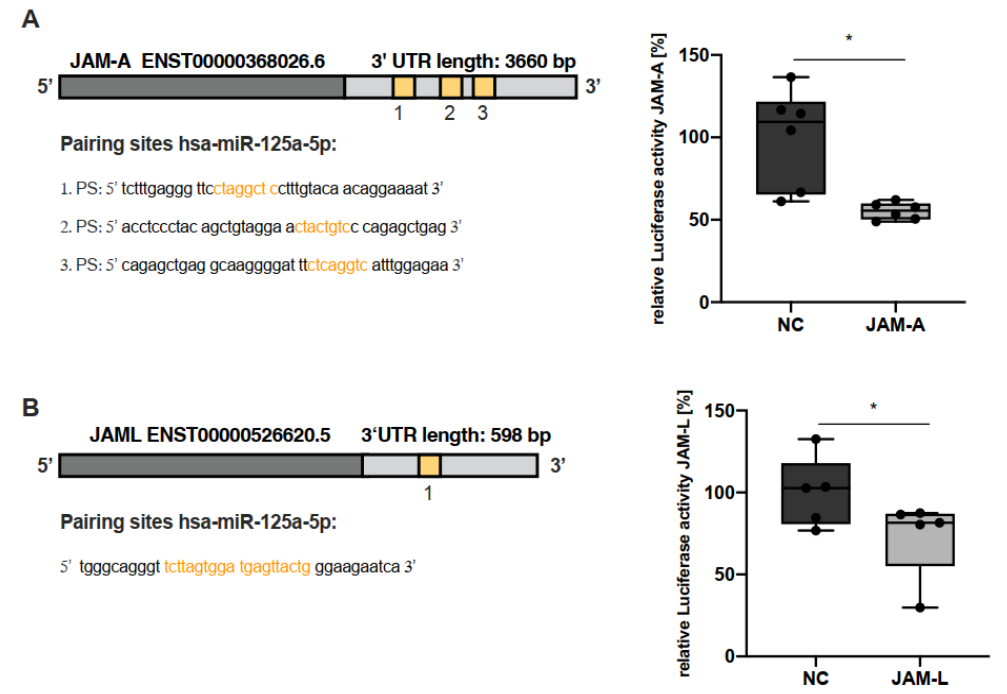
Figure 2. miR-125a directly interacts with the 3 ′ UTRs of JAM-A and JAM-L. ( A ) Localisation of the three in silico-predicted miR-125a binding sites within the 3′ UTR of JAM-A. The relative JAM-A 3′ UTR luciferase reporter gene activity after cotransfection of the luciferase constructs with miR or scrambled control (NC) (n = 6, * p < 0.05). ( B ) Schematic representation of the in silico-predicted miR-125a binding site within the JAM-L 3′ UTR. JAM-L 3′ UTR luciferase reporter gene activity after cotransfection of the luciferase constructs with miR-125a or scrambled control (NC), normalised to firefly luciferase (n = 5, * p < 0.05).